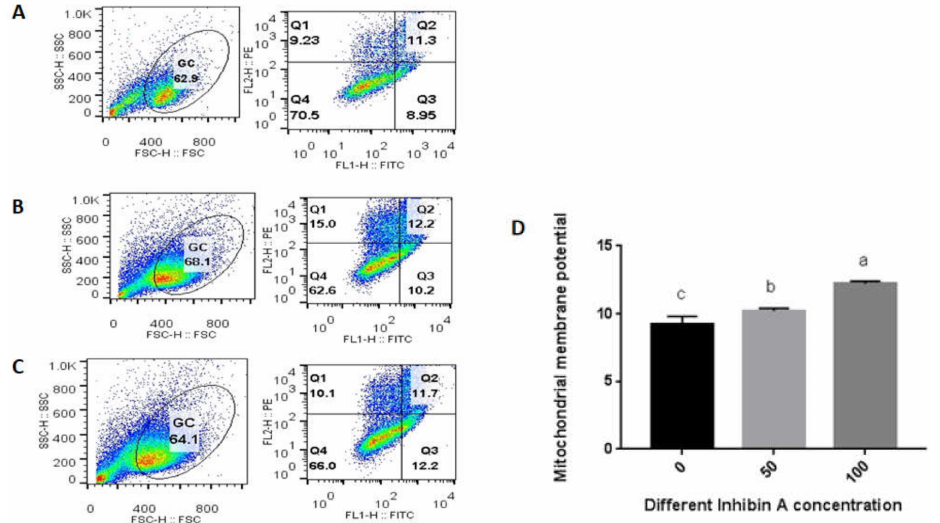
Figure 4. Flow cytometric analysis of GCs cultured under the treatments of di ff erent inhibin A doses (0, 50, and 100 µ g / mL) ( A – C ), respectively. The analyzed cell counts for MMP are indicated on the Y axis and the doses of inhibin A are indicated on the X axis ( D ). Values are expressed as mean ± SEM of n = 3. The bars labeled with completely di ff erent letters indicate a significant di ff erence, p <